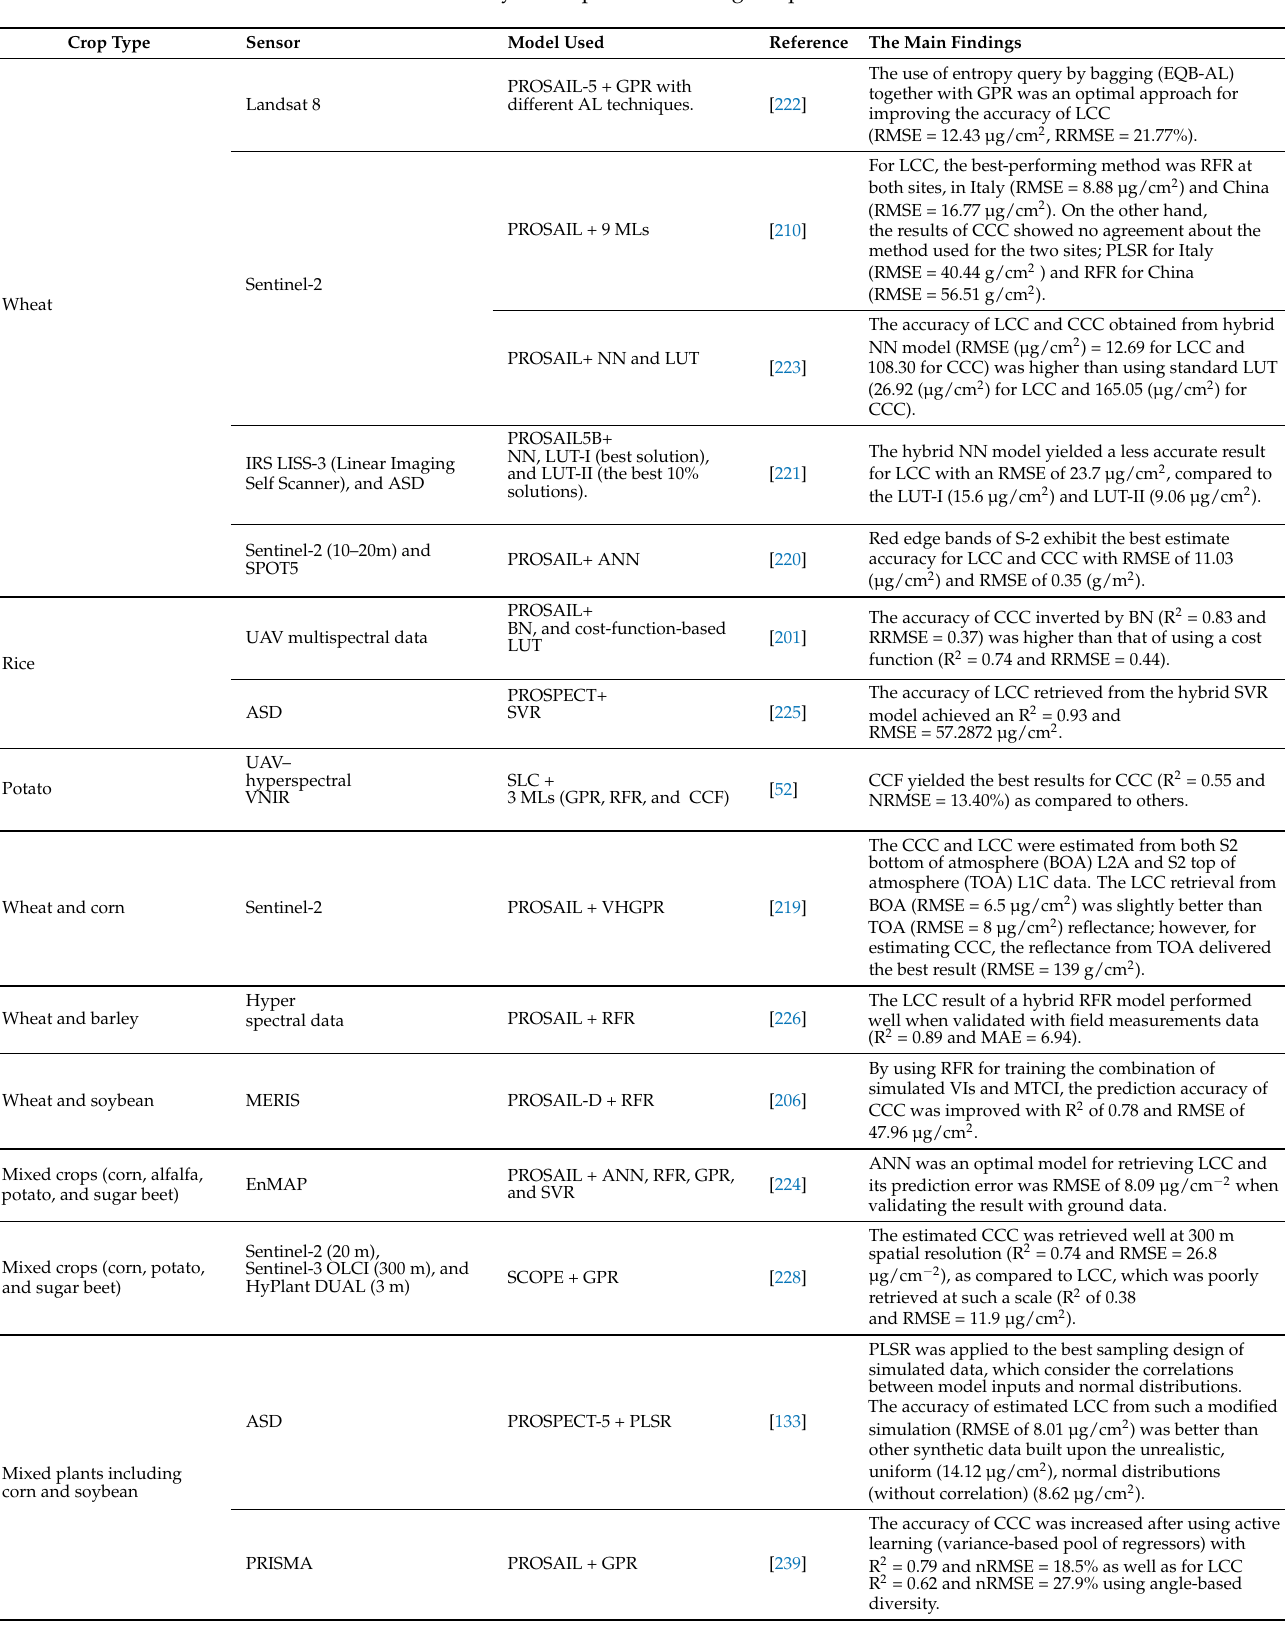
Table A6. Summary of CC prediction using nonparametric